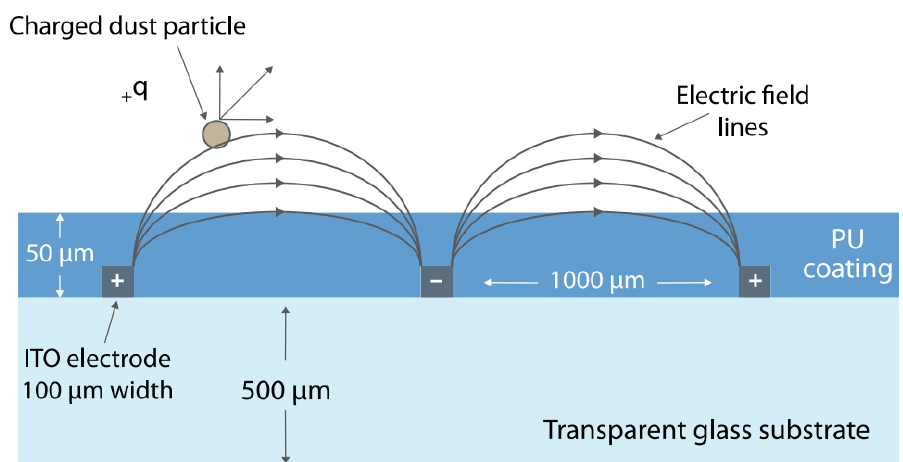
Figure 23. Electrodynamic screen cross-section view. Reprinted from Renewable and Sustainable Energy Reviews, 22, Sarver T. et al., A comprehensive review of the impact of dust on the use of solar energy: History , investigations, results, literature, and mitigation approaches, 698 ‐ 733., Copyright (2013), with permission from Elsevier [73].